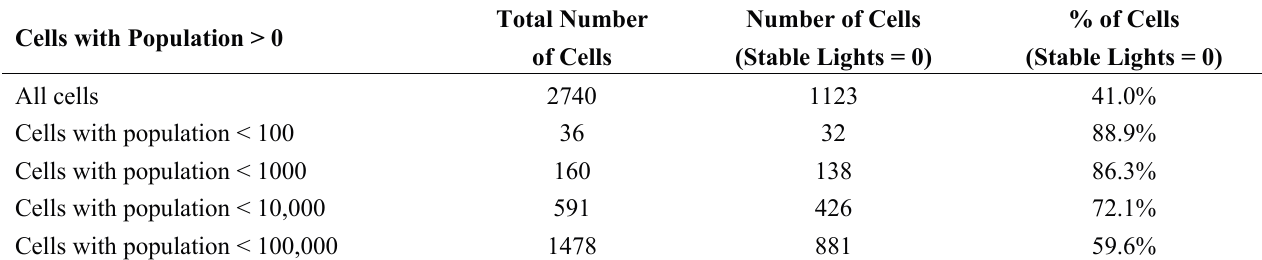
Table 1. Fraction of samples with zero values in stable lights.